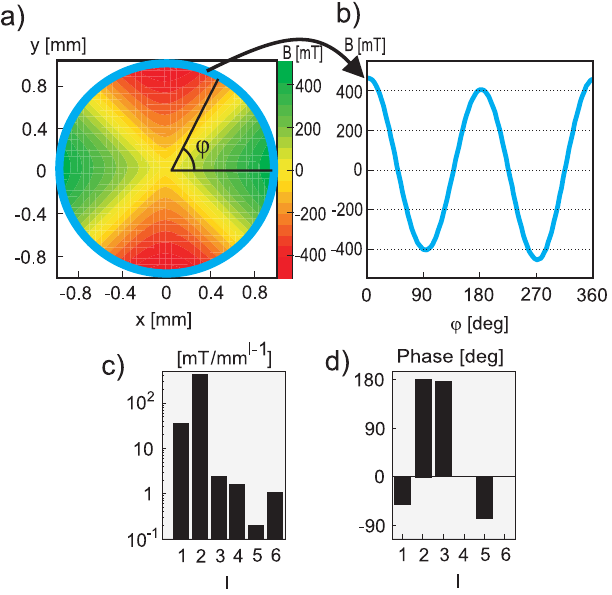
FIG. 3. (Color) Part (a) shows a field measurement using the outermost ring at (cid:1) 0 ¼ 1 mm is plotted against one rotation and used to expand the field coefficients a l and b l , shown in ffiffiffiffiffiffiffiffiffiffiffiffiffiffiffiffiffi q a 2 þ b 2 (c) magnitude and (d) phase arctan ð b l =a l Þ l l